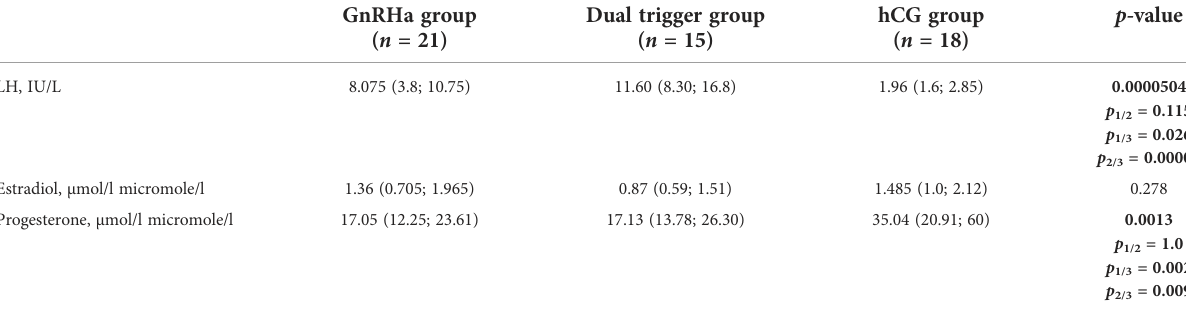
TABLE 3 LH, estradiol, and progesterone concentrations in follicular fl uid. GnRHa group